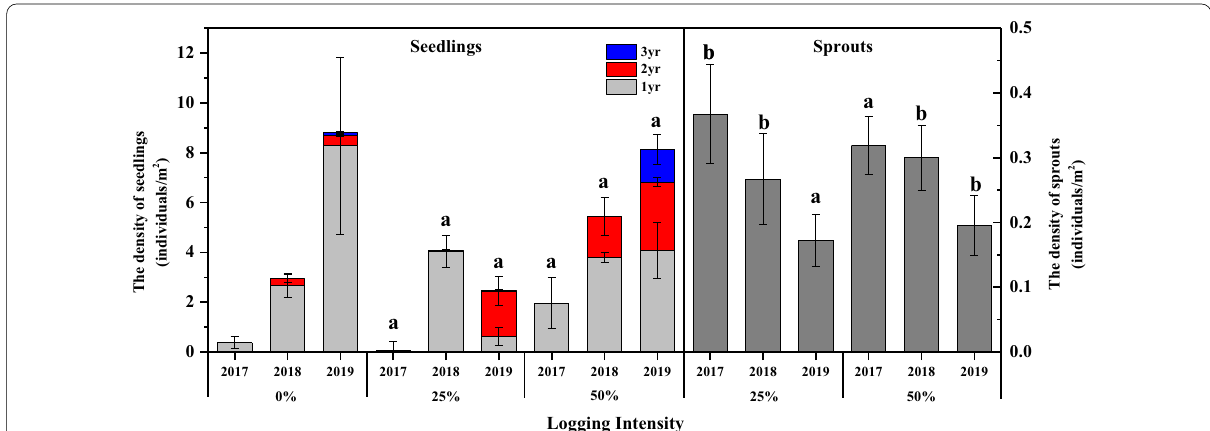
Fig. 4 Seedling (divided into different ages) and sprout density of woody plants for the control (0%), 25% (25% of the basal area removal), and 50% (50% of the basal area removal) logging intensities in August 2017, 2018, and 2019. Different lowercase letters indicate significant differences in densities of two regeneration modes at the same logging intensity and year based on Student’s t -test. The values are presented as the means